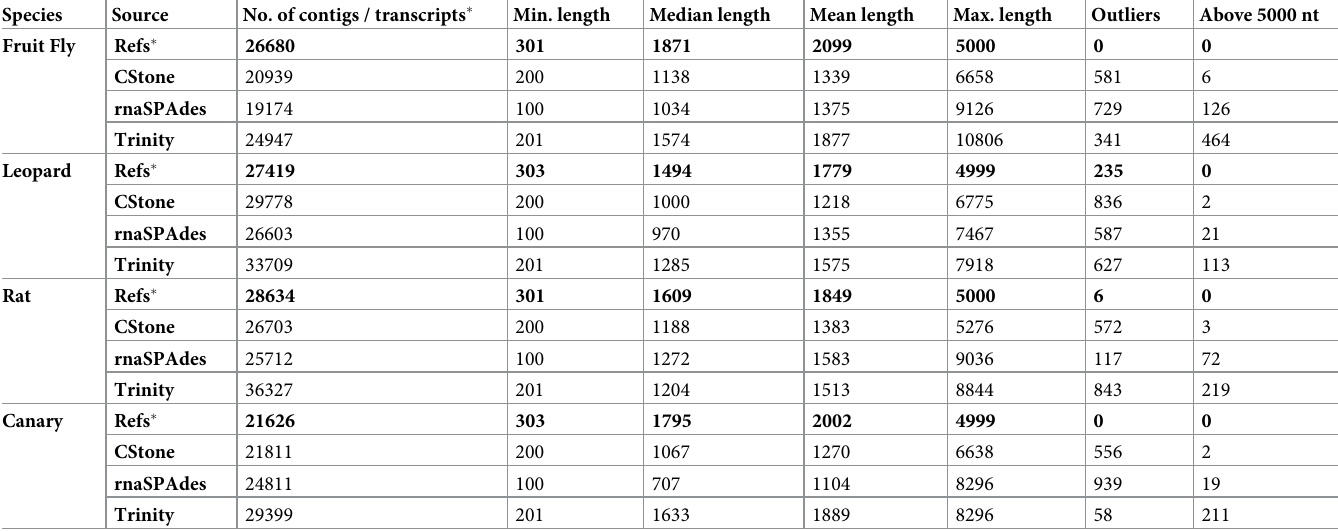
Table 3. Summary of the lengths of assembled contigs relative to the cDNA reference transcripts based on simulated data.